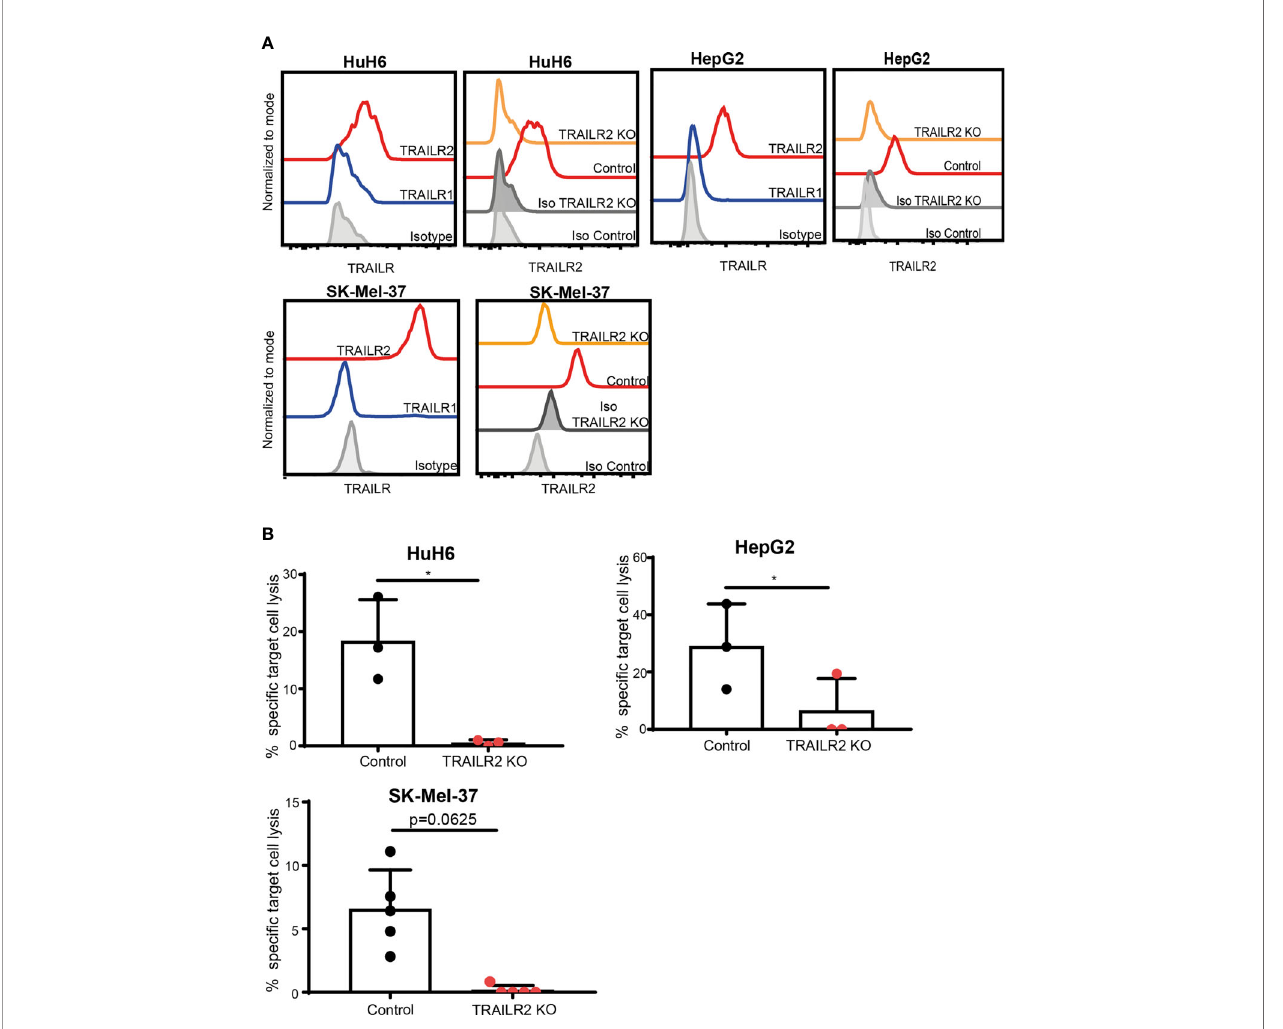
FIGURE 4 | ILC3s kill tumor cells via TRAIL-TRAILR2 pathway. (A) Representative histograms of TRAILR1 and TRAILR2 expression by parental HuH6, HepG2 and SK-Mel-37 cells, and TRAILR2 expression by TRAILR2 KO and control cell lines expressing Cas9. (B) Speci fi c target cell lysis of HuH6 TRAILR2 KO, HepG2 TRAILR2 KO, SK-Mel-37 TRAILR2 KO and the control cell lines expressing Cas9 after 24h co-culture with ILC3s (n=3 blood donors, E:T ratios 4-10:1). *p <0.05, by paired Student ’ s t-test (HepG2 and HuH6); p=0.0625 by Wilcoxon matched-pairs signed rank test